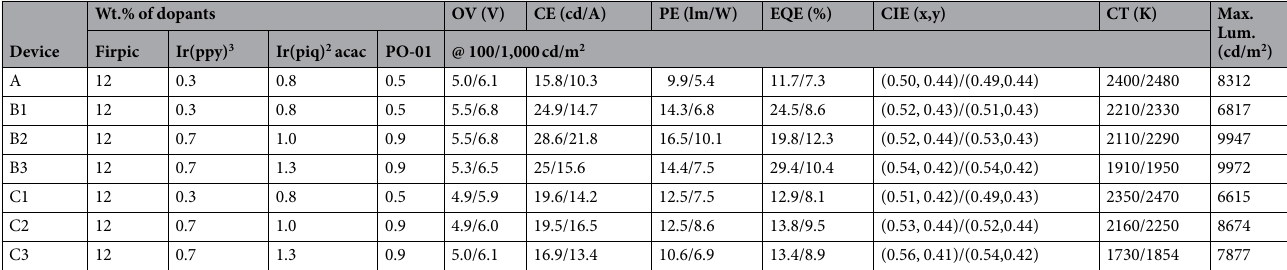
Table 2. Effects of co-host, doping concentration and incorporation of a hole transporting layer on the operation voltage (OV), power efficiency (PE), current efficiency (CE), and external quantum efficiency (EQE), CIE coordinates, color temperature (CT), and maximum luminance of the studied wet-procesed OLED devices with a single emissive